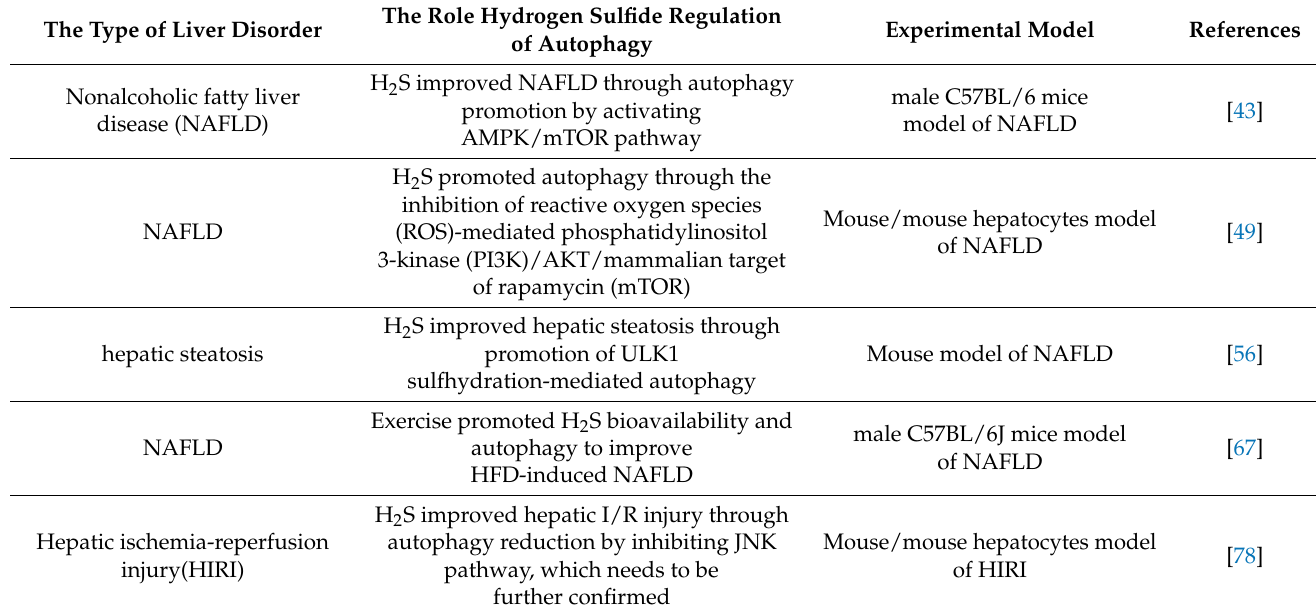
Table 1. The summary of the role of hydrogen sulfide regulation of autophagy in liver disorders. The Type of Liver